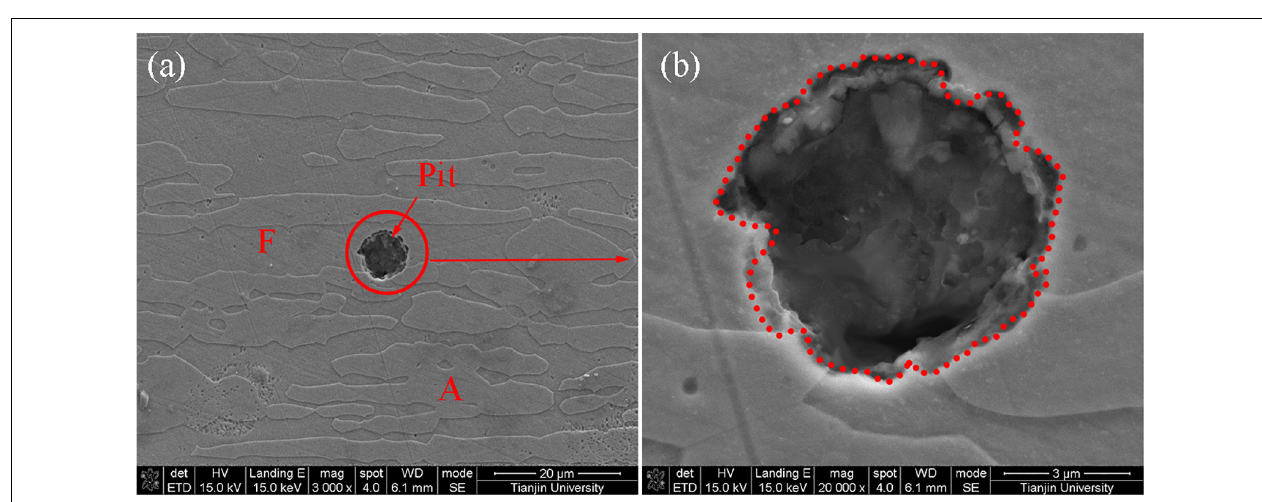
FIGURE 8 | Pits morphologies in BM after CPT tests: (a) SEM and (b) high-magnification